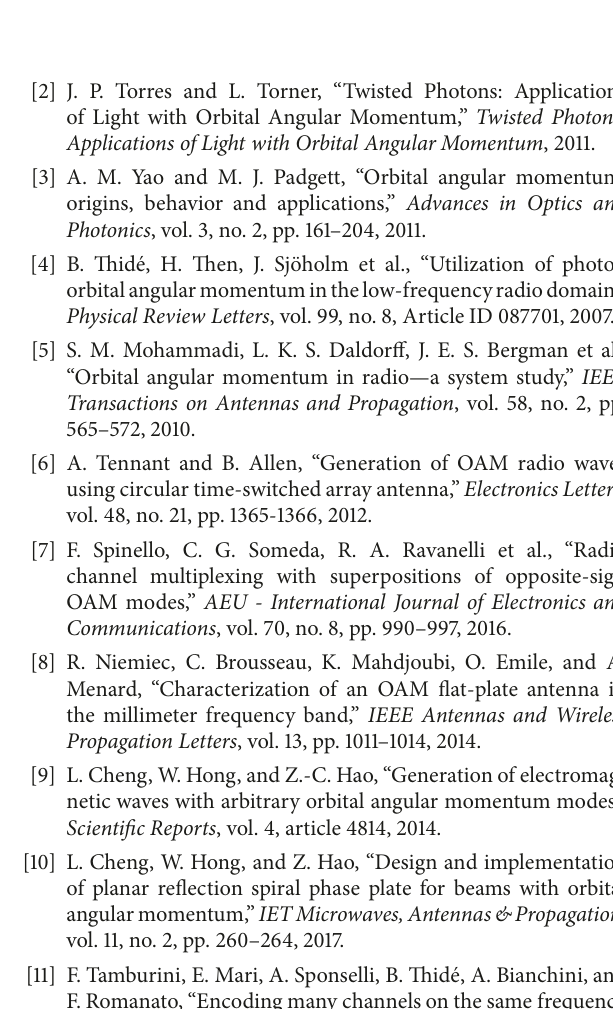
Figure 15: Field characteristics of two OAM modes under the third setup with different polarization probes. (a, e) and (b, f) refer to the field characteristics of OAM modes 1 and 2 measured with horizontal polarization probe, while (c, g) and (d, h) are the field characteristics of OAM modes 1 and 2 measured with the vertical polarization probe.